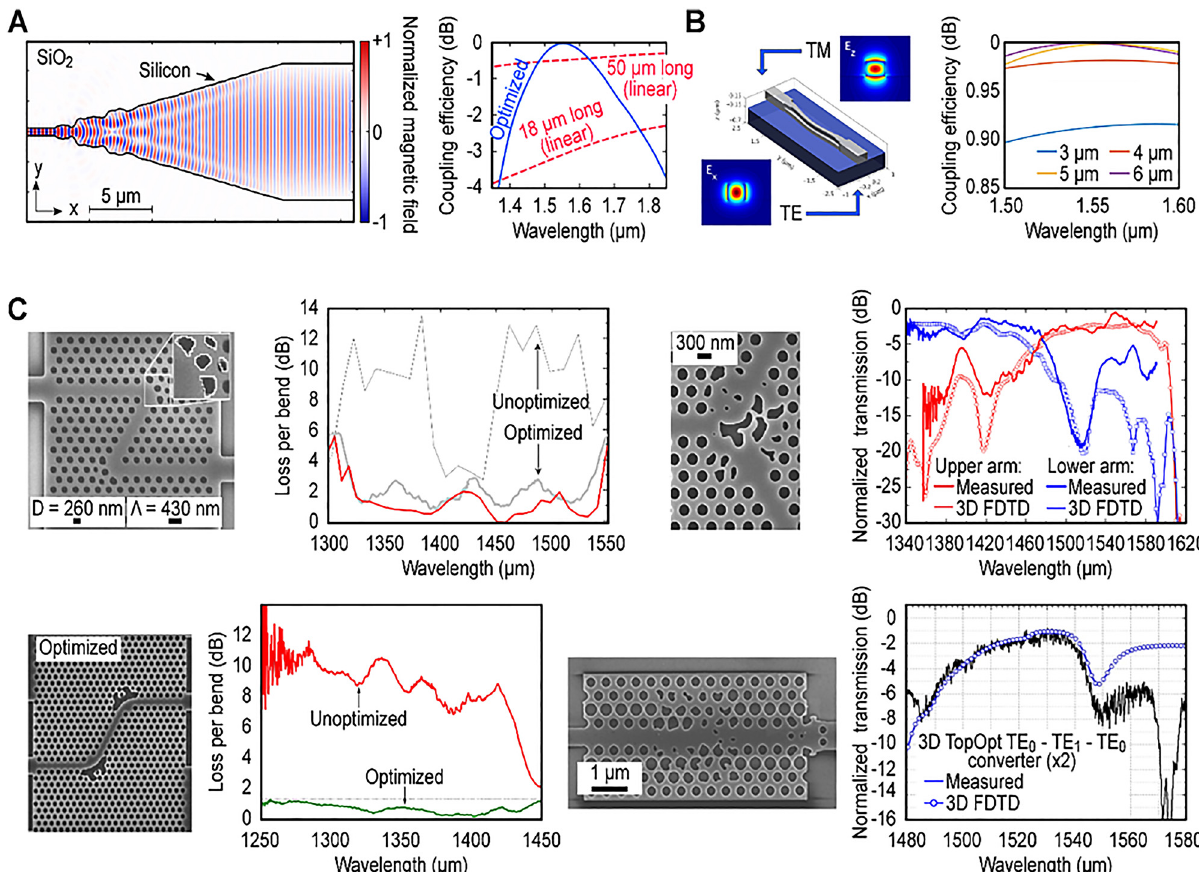
Figure 4: Illustration of the shape optimization and TO algorithms. (A) Non-adiabatic waveguide taper. Left: optimized structure overlaid with the real part of the frequency domain. Right: coupling efficiency of the designed taper. Reproduced with permission [69]. Copyright 2018, Optical Society of America. (B) Left: Schematic of a two-level photonic polarization rotator. Right: the polarization conversion ef fi ciency of the rotator for different lengths. Reproduced with permission